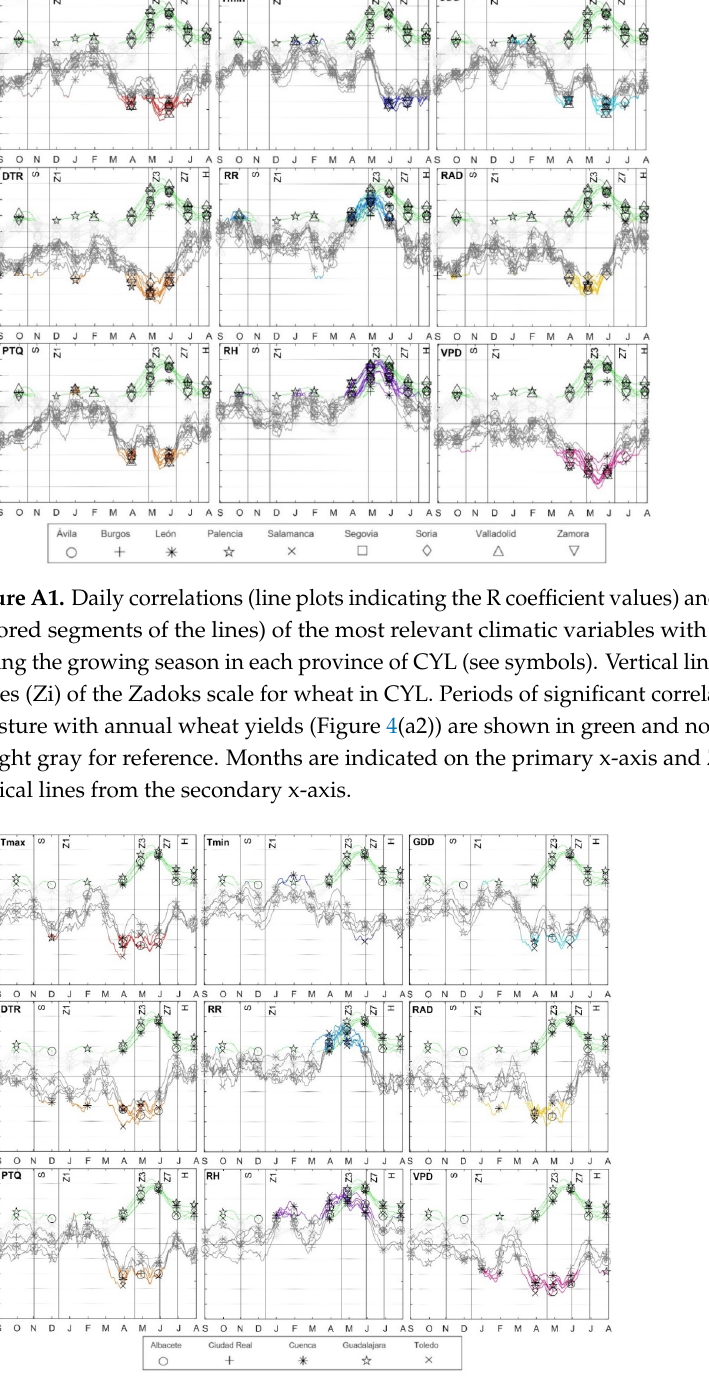
Figure A2. Daily correlations (line plots indicating the R coefficient values) and periods of significance (colored segments of the lines) of the most relevant climatic variables with annual yields of wheat during the growing season in each province of CLM (see symbols). Vertical lines indicate phenological stages (Zi) of the Zadoks scale for wheat in CLM. Periods of significant correlation of ERA5-Land soil moisture with annual wheat yields (Figure 4(a4)) are shown in green and nonsignificant periods are in light gray for reference. Months are indicated on the primary x-axis and Zadok’s stages over the vertical lines from the secondary x-axis.